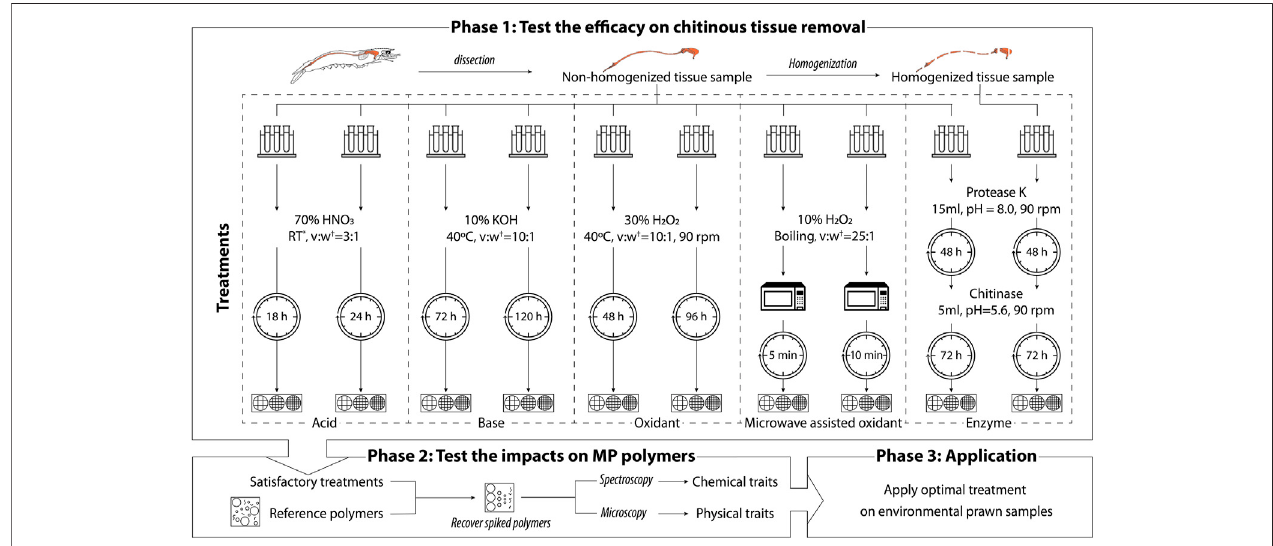
FIGURE 2 | Schematic summary of the microplastic extraction treatments on prawn digestive tracts. * RT — room temperature (approx. 22 – 24 ° C). † v:w is the proportion between the volume of chemical added and the wet weight of the tissue sample.